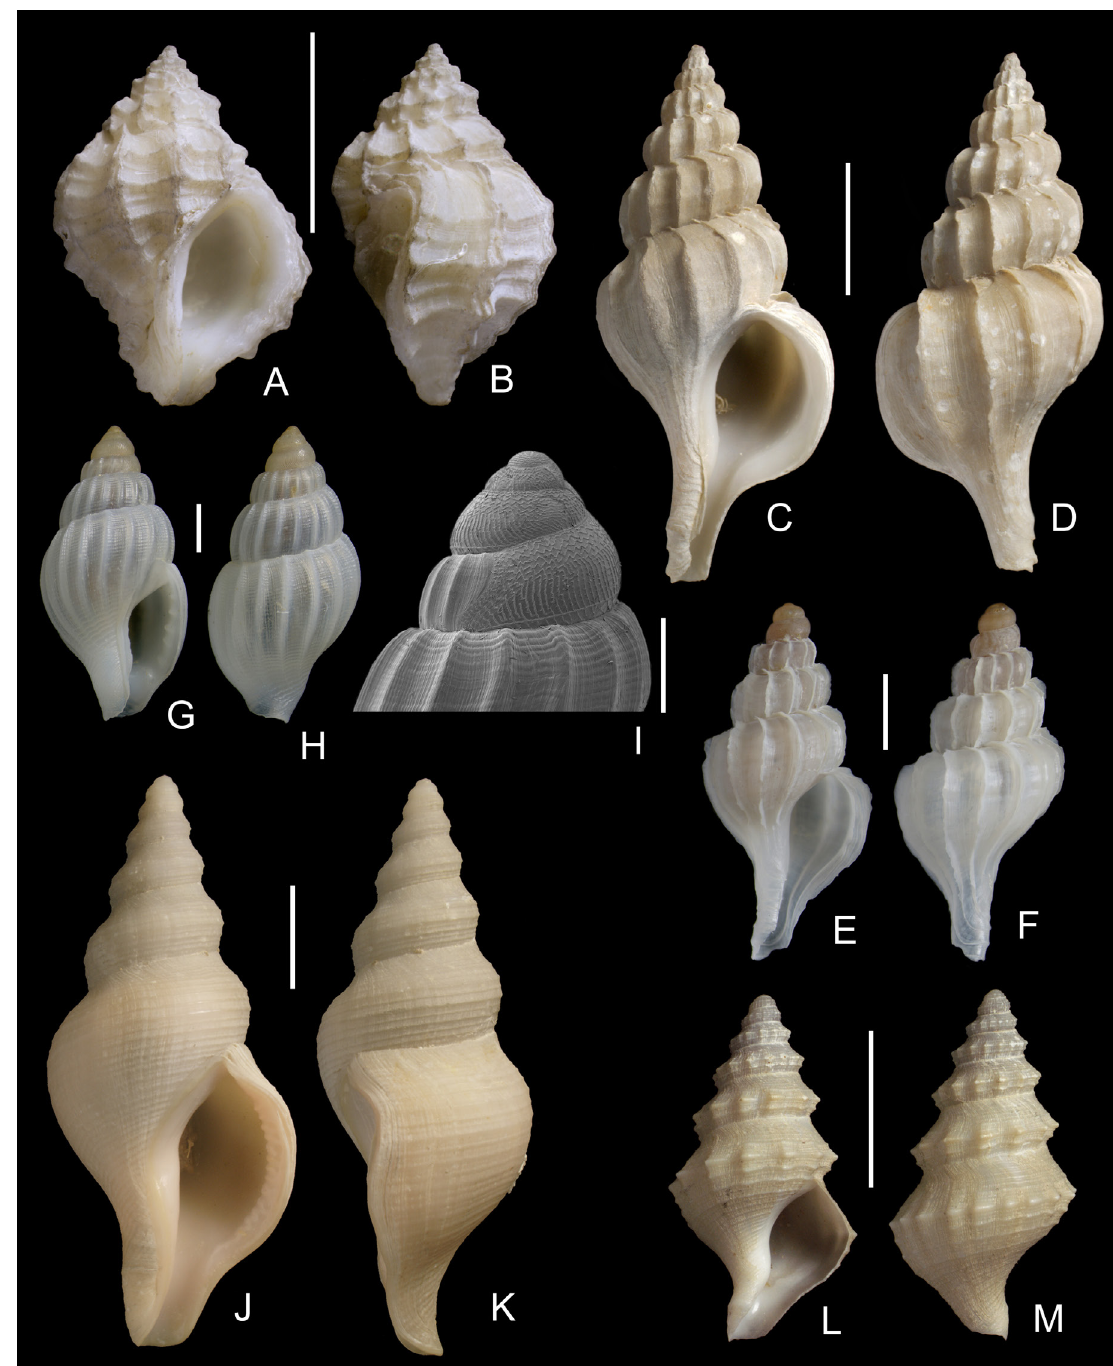
Fig. 23. Muricidae, Fasciolariidae, Columbellidae, Buccinidae, Colidae. A–B . Coralliophila richardi (P. Fischer, 1882), SEAMOUNT 1, DW106, 765 m, 17.9 mm. C–D . Boreotrophon dabneyi (Dautzenberg, 1889), BANGAL 0711, V5, 1631 m, 40.8 mm. E–F . B. dabneyi , juvenile specimen with well-preserved brown protoconch, BANGAL 0711, V2, 1706 m, 4.7 mm. G–H . Amphissa acutecostata (Philippi, 1844), SEAMOUNT 1, DW116, 985–1000 m, 6.0 mm. I . A. acutecostata , protoconch of another specimen, SEAMOUNT 1, CP117, 770 m. J–K . Troschelia berniciensis (King, 1846), ECOMARG 0709, V4, 735 m, 55 mm. L–M . Kryptos koehleri (Locard, 1896), BANGAL 0711, V8, 1565 m, 22.0 mm. Scale bars: A–D, J–M = 10 mm; E–H = 1 mm; I = 500